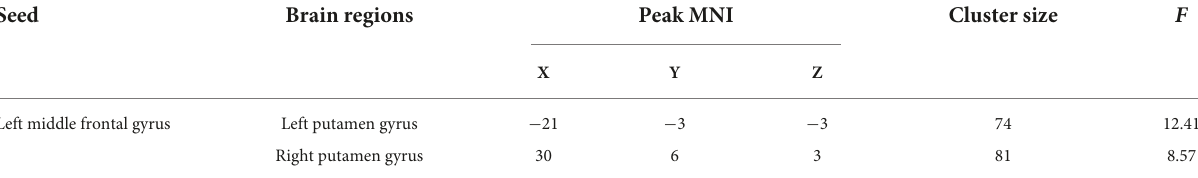
TABLE 4 FC differences between left middle frontal gyrus seed and left putamen gyrus and right putamen gyrus in MDD with childhood trauma, MDD without childhood trauma, and HC.